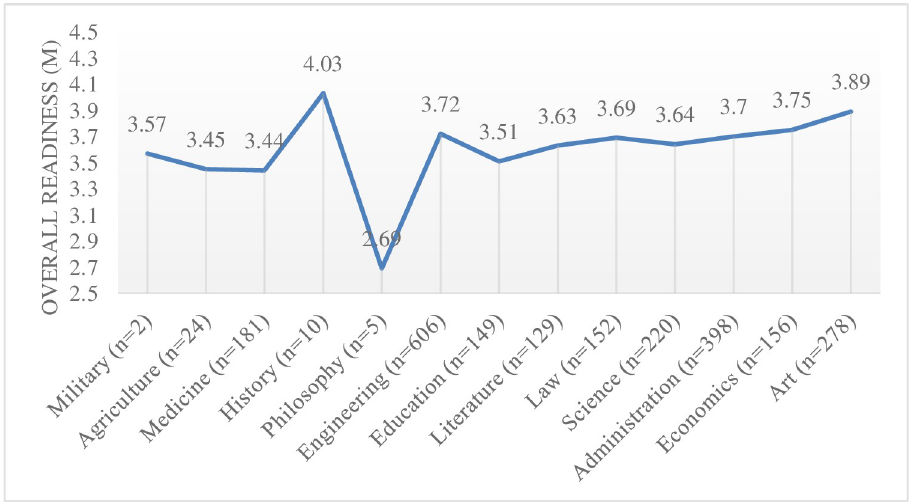
Fig 1. Overall readiness (M) of students from different disciplinary